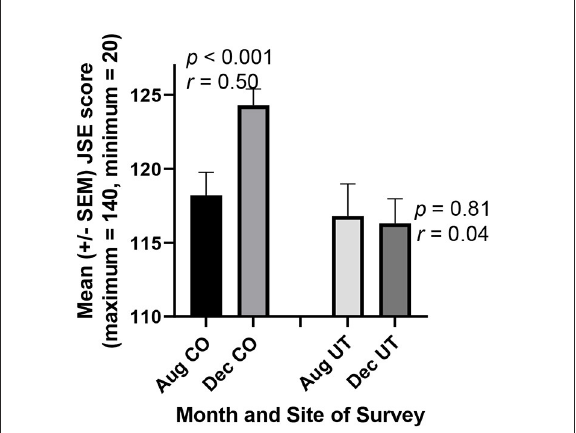
FIGURE1 Prospective medical students Jefferson Scale of Empathy (JSE) scores increased in association with a Medical Humanities course requiring reflection on a team service-learning project (CO). But no increase was observed in an otherwise similar course where service to the community was not required (UT). In Colorado (CO), 40 of 43 students completed the scale both before the course began in August and after its completion in December, so their scores could be paired for more powerful statistical analysis (paired t -test). Similarly, 30 of 32 students in Utah (UT) completed the scale both prior to and following the course.